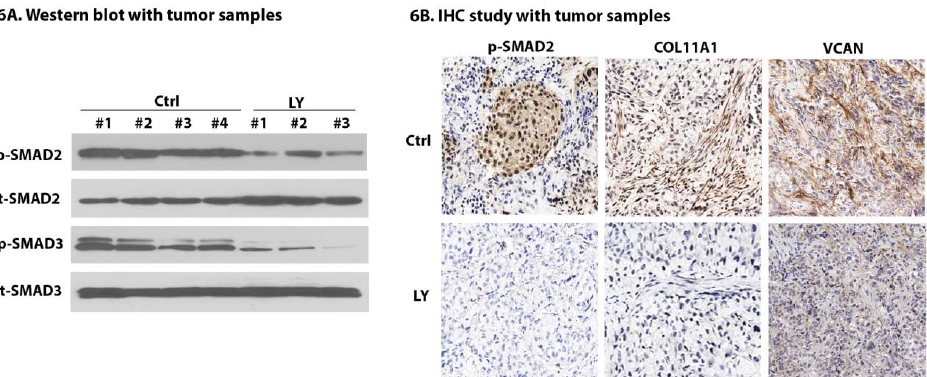
Figure 6. LY downregulates TGF- β signaling and expression of collagen type XI chain 1 (COL11A1) and versican VCAN in vivo. ( A ) Total protein lysates were collected from control ( n = 4) and LY-treated mice ( n = 3) in the OV8-CDX model. Western blot was performed to assess the expression of p-SMAD2 and p-SMAD3. Total SMAD2 and SMAD3 were used as loading controls. ( B ) IHC was performed to measure the expressions of p-SMAD2, COL11A1, and VCAN following LY treatment in OV8-CDX tumors. Magnification, 40 ×